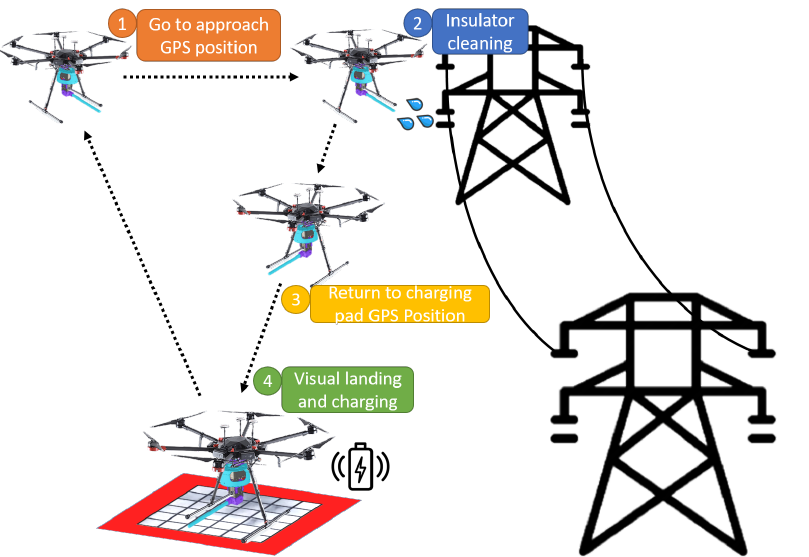
Figure 1. Conceptual design of the operation. ( 1 ) The UAV is sent to the GPS position of an insulator. ( 2 ) Visual local control is performed while locating and cleaning the areas that need the maintenance of the insulator. ( 3 ) When the operation is finished or batteries need to be recharged, the UAV returns to the GPS position of a charging station. ( 4 ) When it reaches the position, an autonomous vision-based descent is performed.